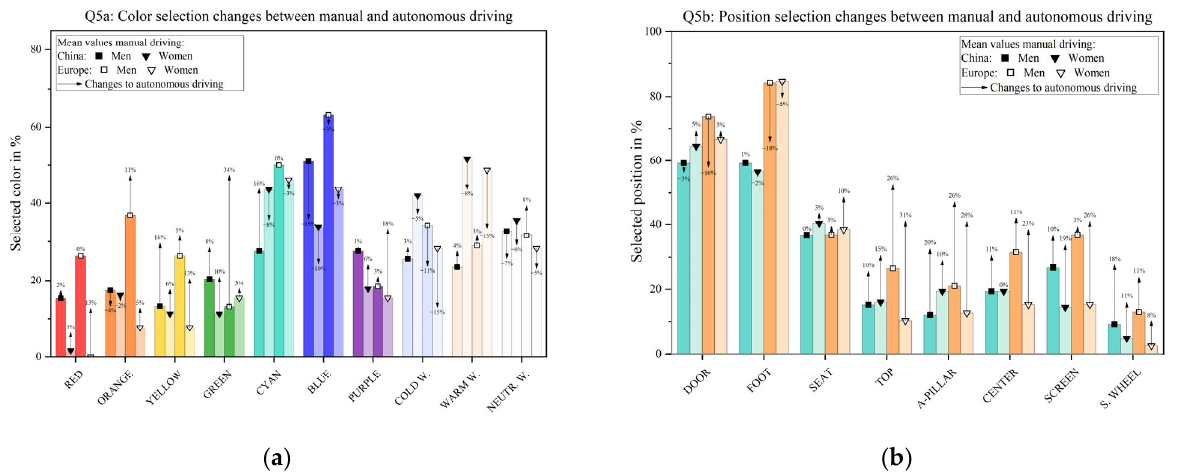
Figure 8. ( a ) Light ‐ color and ( b ) light ‐ positioning selections shown in bars for manual driving and percentage changes to autonomous driving are added in black arrows including numeric, separated between the Chinese and European groups and genders.